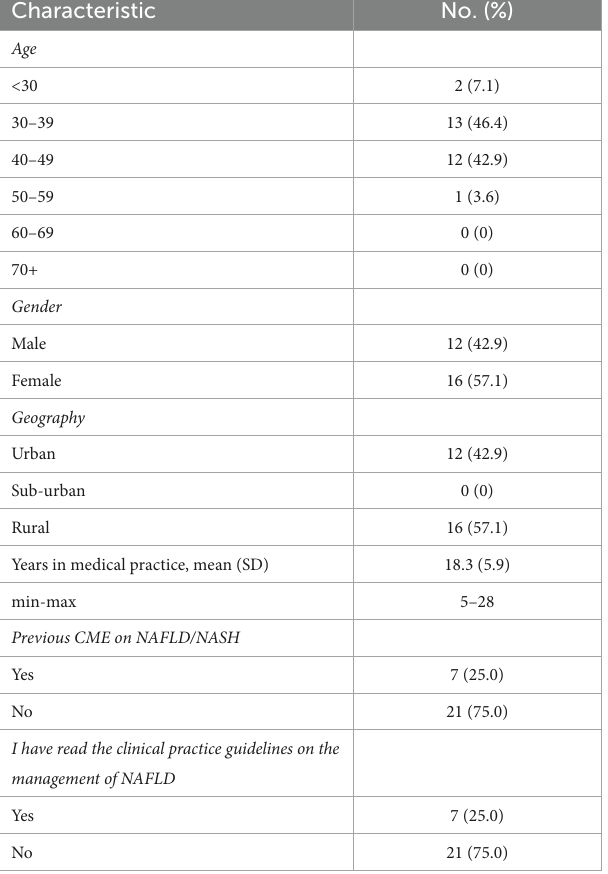
TABLE 1 Characteristics of general practitioners who participated in the feasibility study ( n = 28). Characteristic